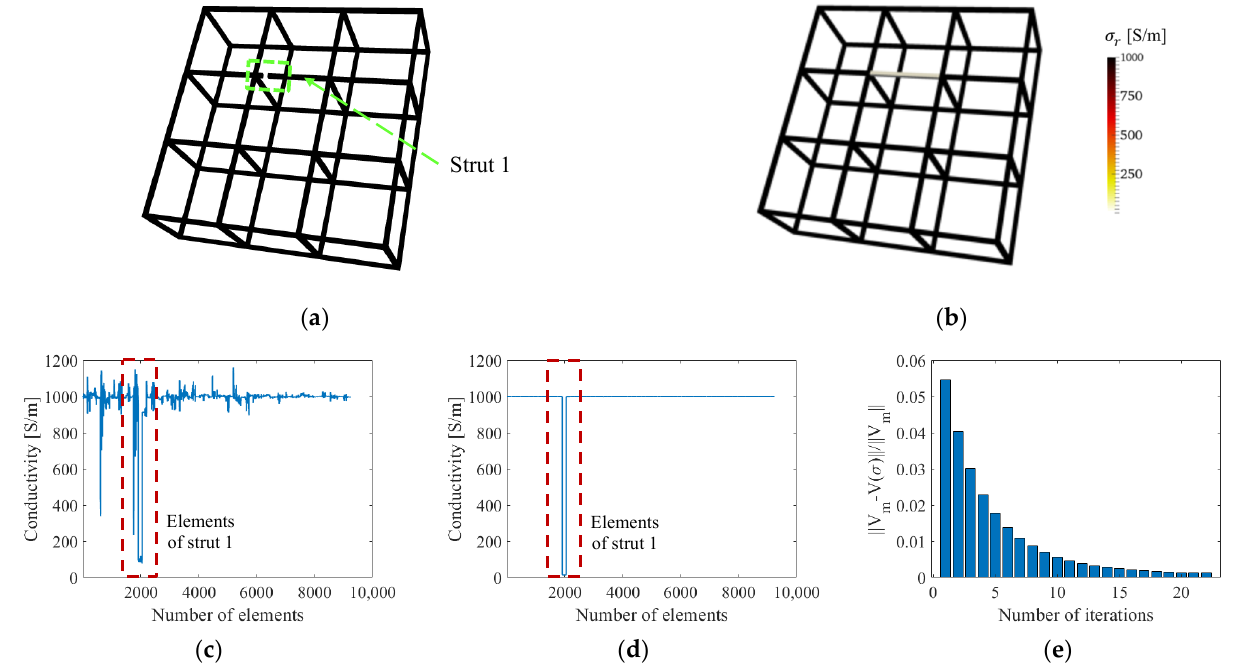
Figure 6. ( a ) A lattice structure was imposed with damage. ( b ) An ERT reconstruction was solved with the normalized sensitivity map. ( c ) The reconstructed conductivity values of each element when solved without and ( d ) with the normalized sensitivity map are plotted. ( e ) The normalized errors are plotted with iterations. Table 1. Image errors quantification and comparison of single-defect reconstructions in